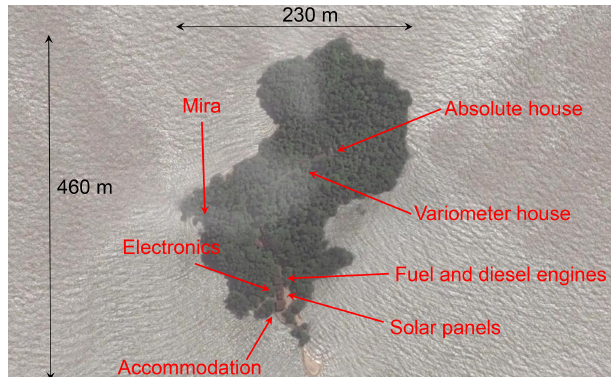
Figure 3. Satellite image of Tatuoca island (copyright 2016 Google). The main buildings and infrastructure of the observatory are marked and annotated.